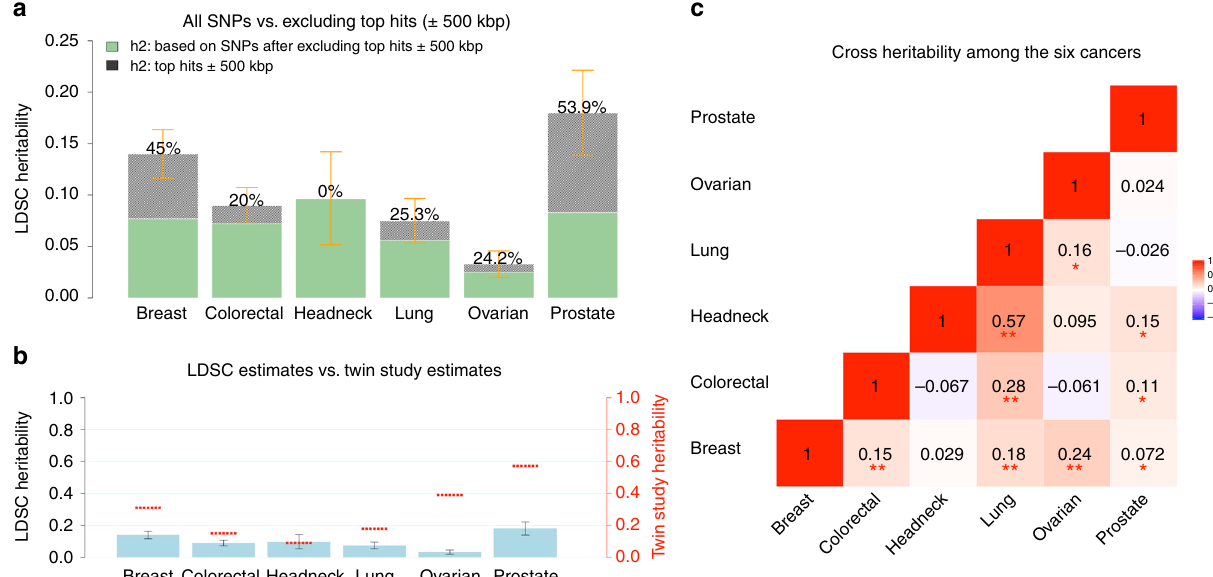
) and cross-cancer heritability ( r g ) for the six cancer types. SNP-heritability and cross-cancer heritability are Fig. 1 Estimates of SNP-heritability ( h 2 g calculated based on HapMap3 SNPs using LD score regression (LDSC). a The solid bar represents overall SNP h 2 on the liability scale, calculated based on g all HapMap3 SNPs. The dark green bar represents h 2 calculated based on non-signi fi cant SNPs — the remaining SNPs after excluding genome-wide g signi fi cant hits ( p < 5 × 10 − 8 ) ± 500 kb. The black bar with density texture indicates proportion of h 2 (as re fl ected by the percentages displayed on top of g each bar) that could be explained by top hits ±500 kb surrounded areas. The orange error bars represent 95% con fi dence intervals. b The solid blue bar represents overall SNP h 2 in liability scale (no SNP exclusion), with black error bars indicating 95% con fi dence intervals. The red short lines correspond to g classical estimates of h 2 measured in a twin study of Scandinavian countries (Mucci et al. 2 ). c Genetic correlations between cancers. Estimates withstood Bonferroni corrections ( p < 0.05/15) are marked with double asterisk (**), and nominal signi fi cant results ( p < 0.05) are marked with single asterisk cancer subtypes adenocarcinoma and squamous cell carcinoma was similarly 0.58 (se = 0.10). Further, we observed a signi fi cantly larger genetic correlation of lung cancer with ER − ( r g = 0.29, se = 0.06) than with ER + breast cancer ( r g = 0.13, se = 0.04) ( p difference = 0.002). This also held true for lung squamous cell with ER − ( r g = 0.33, se = 0.08) than with ER + breast cancer ( r g = 0.11, se = 0.05) ( p difference = 0.0019). We observed no other